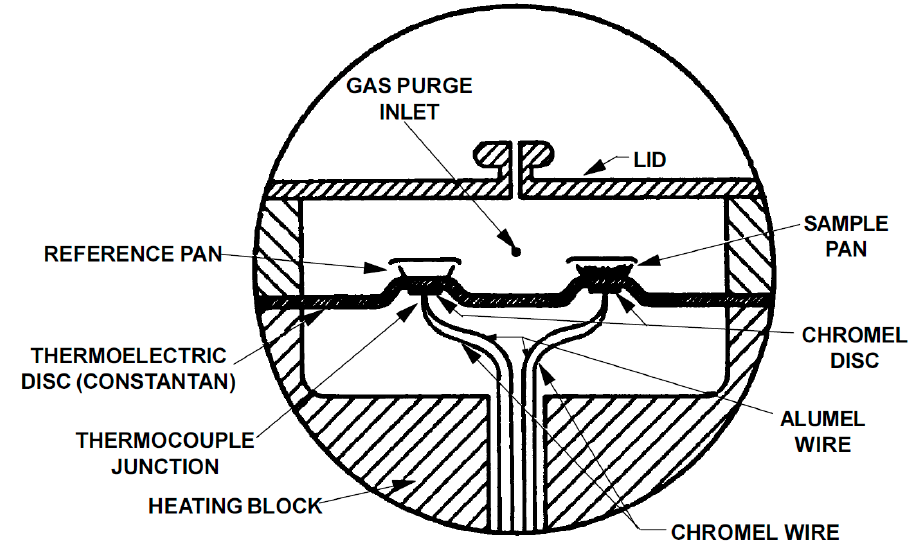
Figure 7. Schematic of the differential scanning calorimetry method. Reprinted with permission of Elsevier [116].